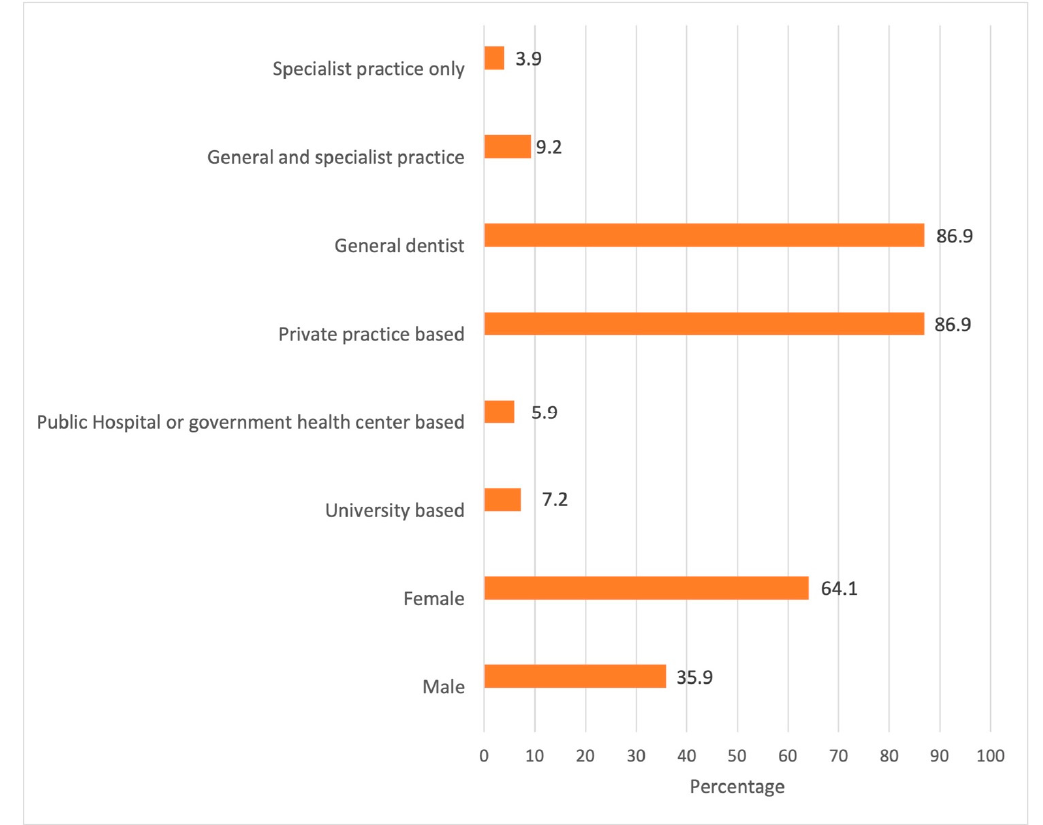
Figure 1. Characteristics of the selected sample in percentages.